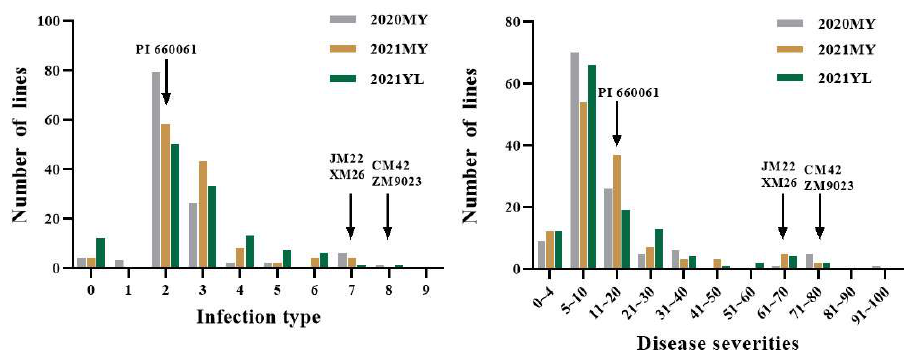
Figure 2. Adult-plant stripe rust reactions on leaves of five parents and susceptible control M169 ( A ); phenotype of sixteen final selected posterities, IT = 0 (including BC 2 F 6 -73), IT = 1 (including BC 2 F 6 -21, BC 2 F 6 -86, BC 2 F 6 -97), IT = 2 (including BC 2 F 6 -28, BC 2 F 6 -48, BC 2 F 6 -59, BC 2 F 6 -65, BC 2 F 6 -84, BC